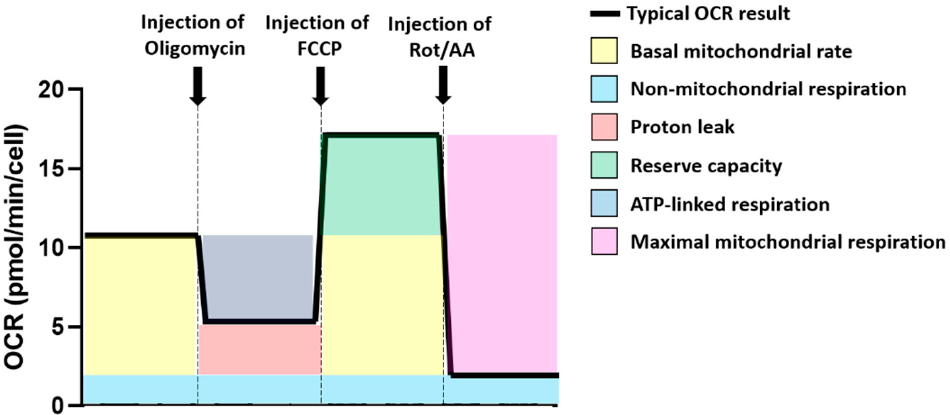
Figure 5. Use of the Oxygen Consumption Rate (OCR) profile to calculate mitochondrial and non-mitochondrial-related metabolic and oxygen consumption parameters. Different colours have been used to represent the different OCR parameters that have been calculated for these experiments. (yellow) represents the basal mitochondrial rate; (blue) represents non-mitochondrial respiration; (red) indicates proton leak; (green) represents reserve capacity; (navy) represents ATP-linked respiration; (purple) indicates maximal mitochondrial respiration. A bolded black line shows the typical OCR profile. A dashed grey line indicated compound injection points.